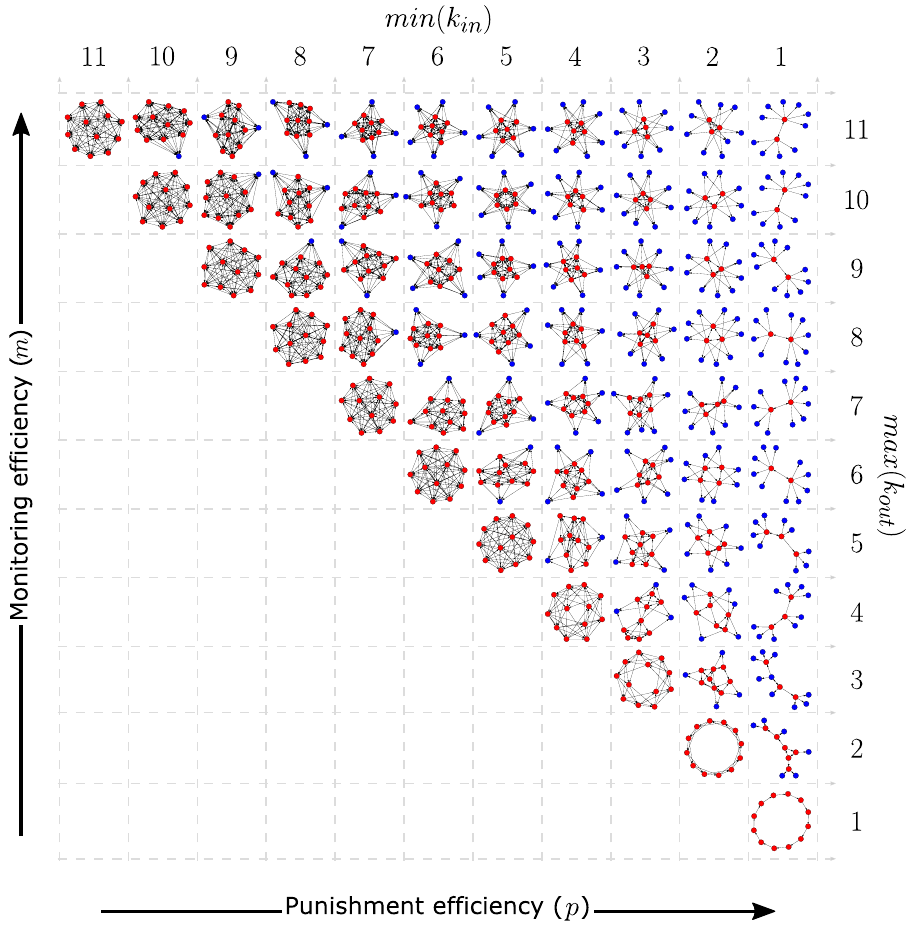
Figure 5. Socially efficient network structures for twelve individuals (nodes) when universal threshold contribution is a Nash equilibrium. The networks shown maximize the division of labor between those with monitoring and punishment responsibilities (red nodes) and those without (blue nodes) and, of those, have the median network hierarchy score from 1 million randomly generated networks. As with the six-node networks in Fig. 4, higher monitoring efficiency corresponds to a higher maximum number of out-links, and higher punishment efficiency corresponds to a lower minimum number of in-links. The optimal network structures range from completely connected, networks indicating distributed monitoring and punishment, at the top left and hierarchically organized monitoring and punishment on the far